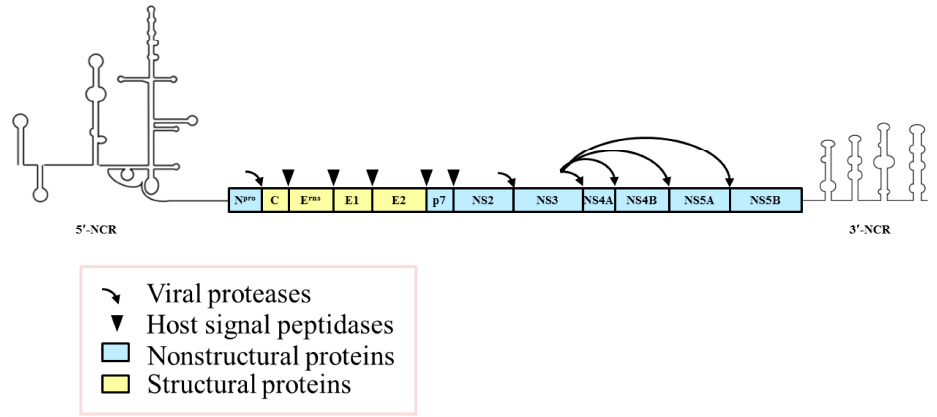
Figure 1. The organization of the classical swine fever virus (CSFV) genome and the encoding proteins. The positive-sense, single-stranded RNA genome of 12.3 kb contains 5 ′ - and 3 ′ -noncoding regions (NCRs) important for viral RNA replication and/or protein translation and a large open reading frame (ORF) that encodes a large polyprotein. The polyprotein is processed into four structural proteins and eight nonstructural proteins by a combination of viral and cellular proteases.